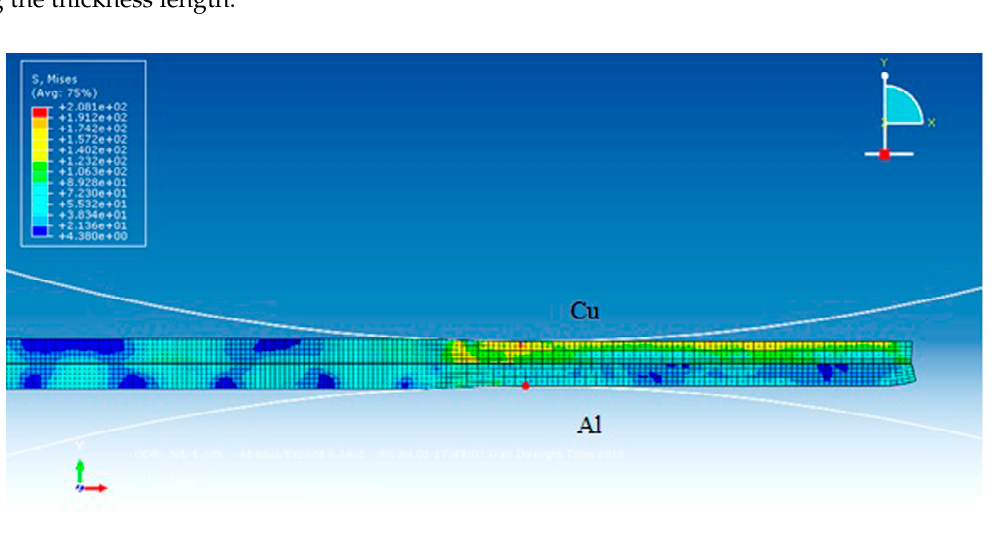
Figure 6. Rolling process of bimetal Al/Cu laminates.